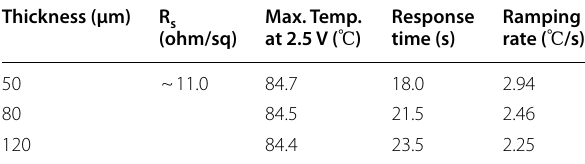
Table 2 Comparison of the performances of the Cu mesh/PVA